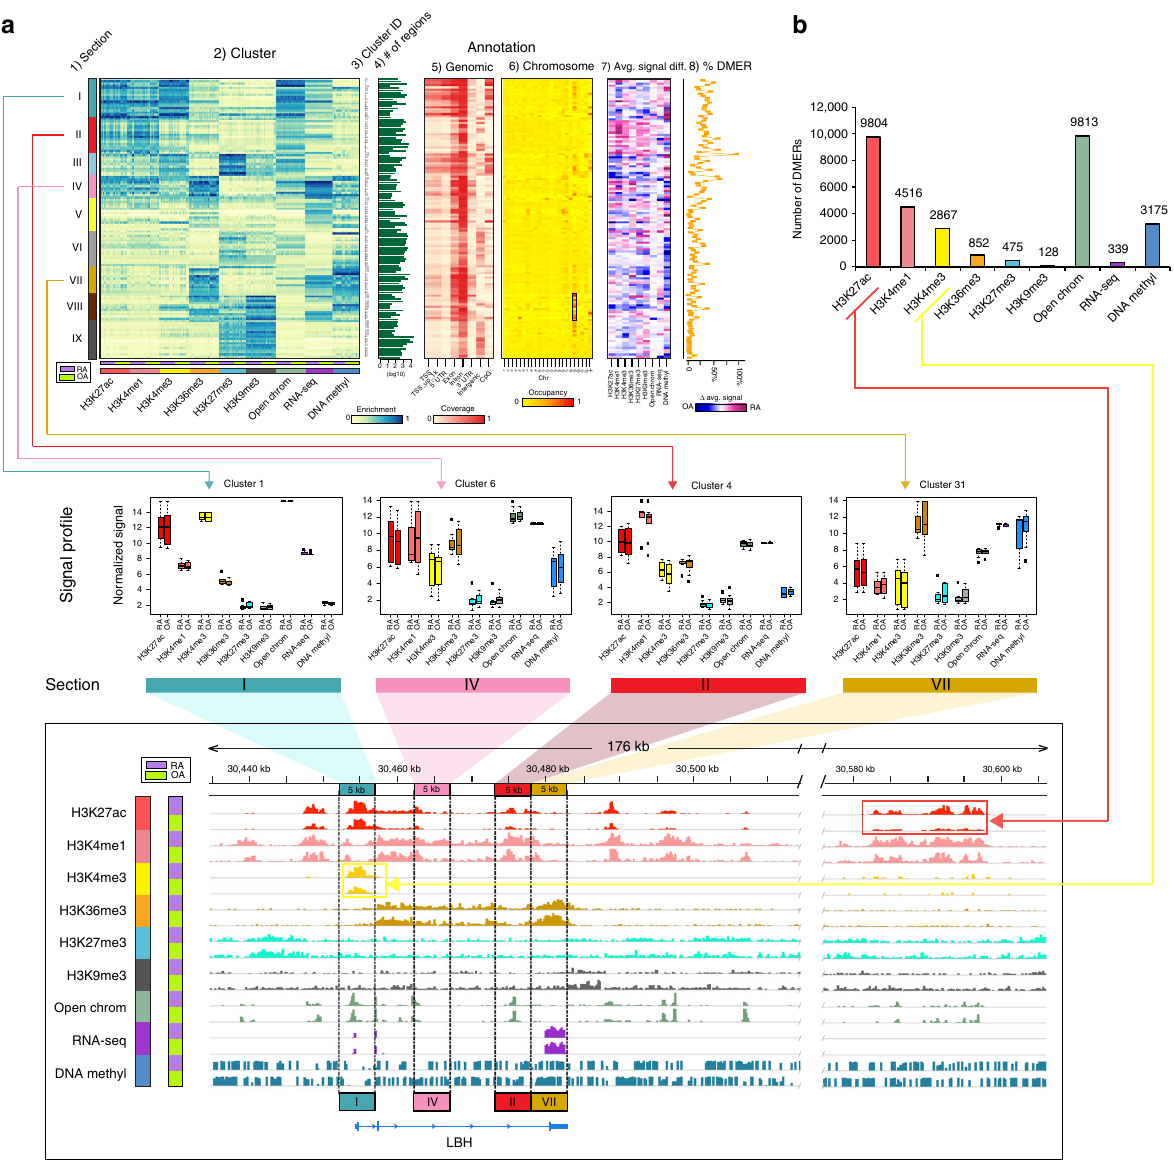
Fig. 2 Genome-wide multidimensional clusters in RA and non-RA genomes. a A total of 125 genome-wide 5 kb multidimensional clusters were grouped into nine sections based epigenetic marks. From left to right of the upper panel shows the aligned 125 clusters, each of which includes 11 RA and 11 OA FLS lines: (1) the organization of clusters into epigenetically de fi ned sections (see text); (2) genome annotation heatmap with coverage of each cluster, with 22 separate FLS lines shown within each cluster; (3) 125 cluster IDs; (4) the number of 5 kb regions in each epigenetic cluster (log10 scale); (5) the characteristics of each region within the clusters, such as the relative abundance of transcription start sites (TSS), gene bodies, or introns; (6) chromosome location of each region within the clusters (box shows high occupancy at chromosome 19); (7) differences in signals of epigenetic marks between RA and OA; and (8) percentage of DMERs each cluster. In the middle panel, boxplot examples of clusters in different sections corresponding to LBH regions in the genome browser (bottom panel) demonstrating differences between RA and OA and how the FLS marks can be categorized as sections I, II, IV, and VII 14 . b DMERs with enhancer and promoter histone marks account for the most common differences between RA and OA. The red and yellow lines connect H3K27ac and H3K4me3 bars to the genome browser, which shows an example of how those marks are differentially modi fi ed between RA and